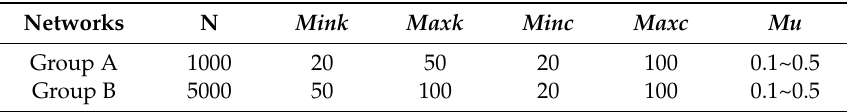
Table 1. LFR benchmark network